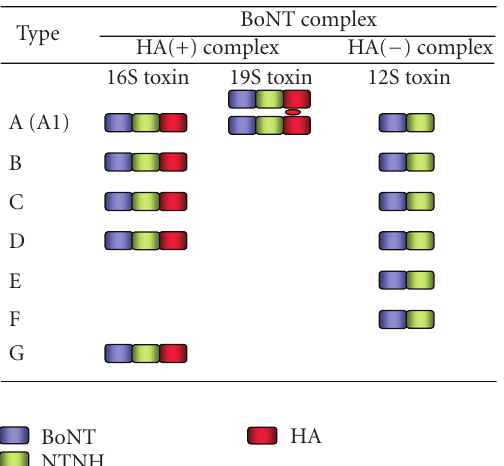
Figure 2: Features of types A to G BoNT complexes. Type A (A1) BoNT is produced by C. botulinum in three forms: 12S, 16S, and 19S toxins. Types B, C, and D BoNT are produced in two forms: 16S and 12S toxins. Types E, F, (and A2) BoNT are produced as 12S toxin. Type G BoNT complex is produced as 16S toxin (reviewed in [3, 6,